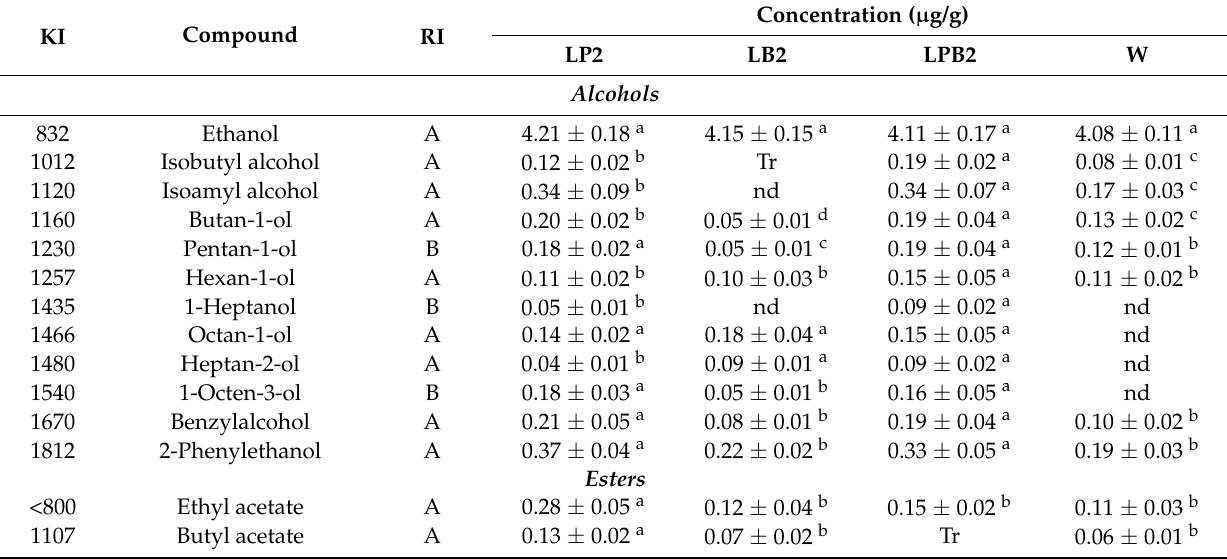
Table 3. Solid-phase microextraction (SPME) gas chromatography/mass spectrometry (GC/MS) analysis of aroma-related compounds ( µ g/g) extracted from breads made with sourdoughs prepared with freeze-dried L. paracasei K5 and freeze-dried L. bulgaricus ATCC 11842 as well as with the control